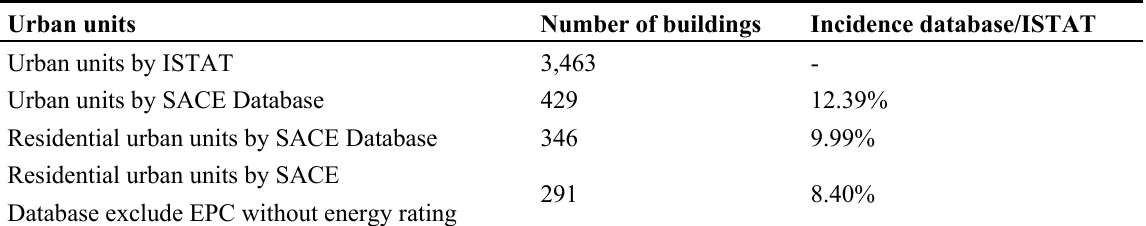
Table 16. Verucchio: ISTAT Data and SACE Database 2011.